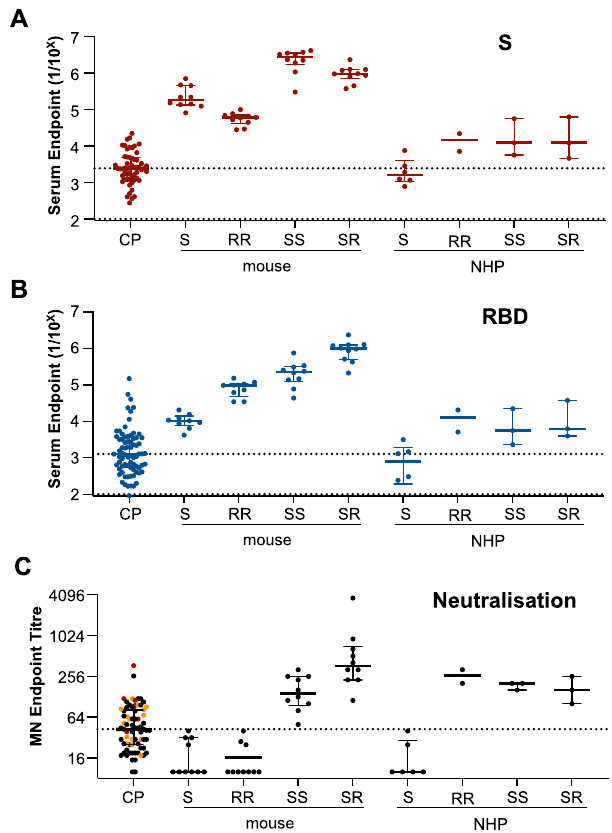
Fig. 4 Comparative serological antibody and neutralising activity against SARS-CoV-2 across mice, macaques and convalescent humans. Serum from mice ( n = 10 per group), and plasma from macaques ( n = 2 for RBD/ RBD group, n = 3 for Spike/RBD and Spike/Spike groups) and human convalescent donors ( n = 72) were assessed for endpoint total IgG titres measured by ELISA against A S or B RBD. C Neutralisation activity in the plasma (human, macaques) or serum (mouse) was assessed using a microneutralisation assay. A – C Dotted lines represent median of human convalescent donors. Severity of infection for the convalescent cohort is indicated as mild (black), moderate (orange) and severe (red). Data are presented as median ± IQR. Source data are provided as a source data fi